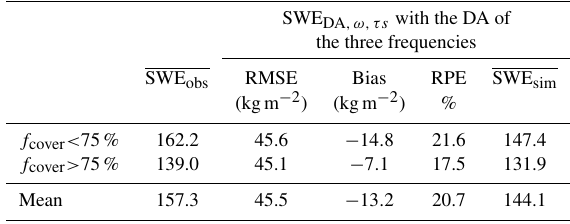
Table 7. Same as Table 6 but using the forest parameter ω and the snow stickiness parameter ( τ snow ) as free variables in the DA scheme (Experiment C) to improve SWE retrievals (SWE DA ,ω,τs